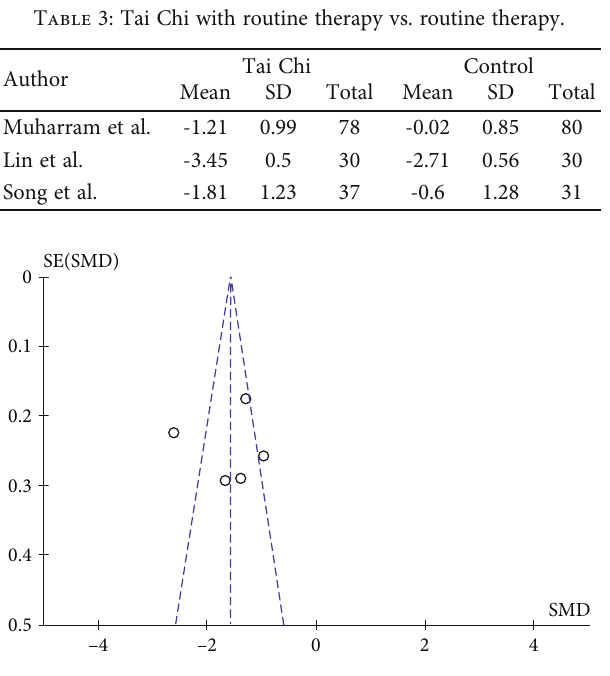
Figure 3: Funnel plot analysis on the e ff ect of Tai Chi for